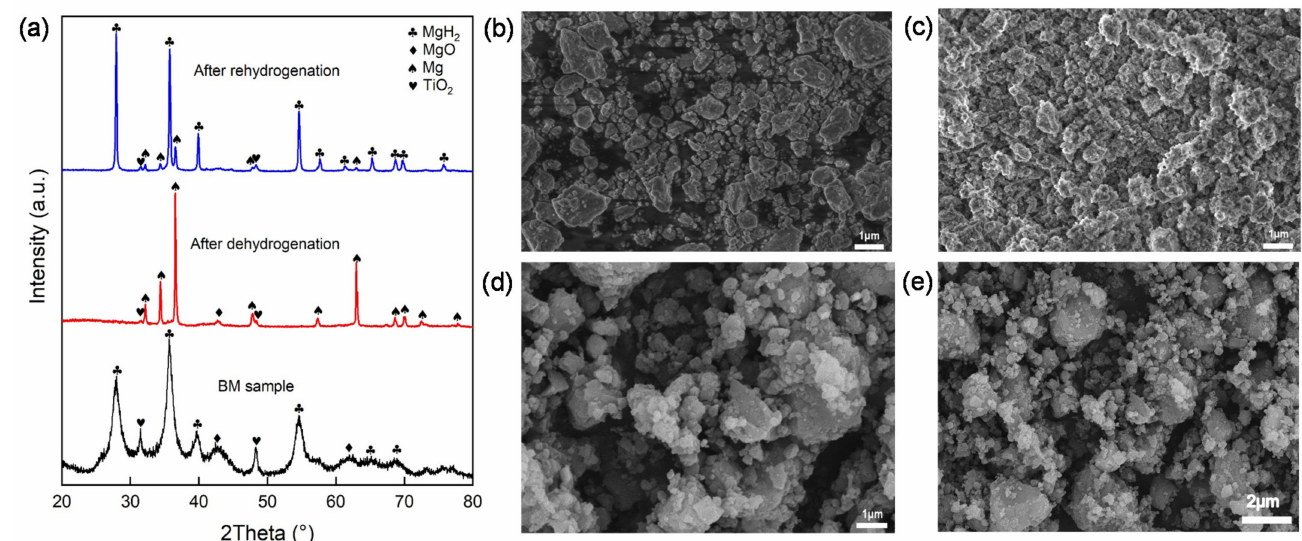
Figure 5. ( a ) XRD patterns of as-milled, dehydrogenative, and rehydrogenative MgH 2 -6 wt.% ML-Ti 3 C 2 . ( b ) SEM image of MgH 2 -6 wt.% ML-Ti 3 C 2 after ball milling. ( c ) SEM image of MgH 2 -6 wt.% ML-Ti 3 C 2 after dehydrogenation. ( d , e ) SEM images of MgH 2 -6 wt.% ML-Ti 3 C 2 after rehydrogenation. Figure 6a,b display the XPS spectra of C 1s and Ti 2p of the as-milled, dehydrogenative, and rehydrogenative MgH 2 -6 wt.% ML-Ti 3 C 2 . The C 1s XPS spectrum can be divided into four peaks: 282.0 eV, 284.8 eV, 286.5 eV, and 288.9 eV, which can be fitted to Ti − C [43], C − C [56], C − O [57], and O=C − O [57], respectively. It can be observed that Ti − C